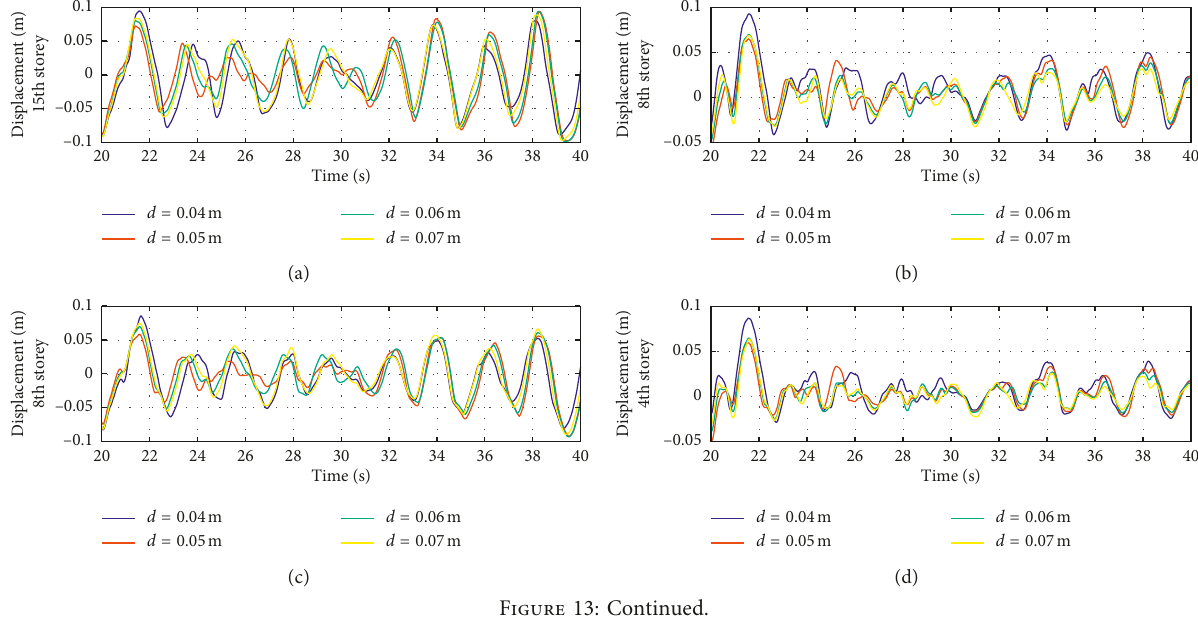
Figure 12: Displacement time-history with different gaps between buildings for (a, c, e) left building storeys and (b, d, f) right building storeys.